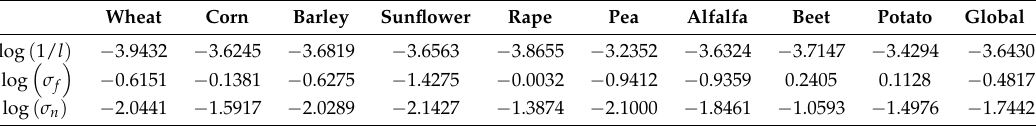
Table 1. Averaged hyperparameters estimated using fixed crop-type and global apporaches. Corn Barley